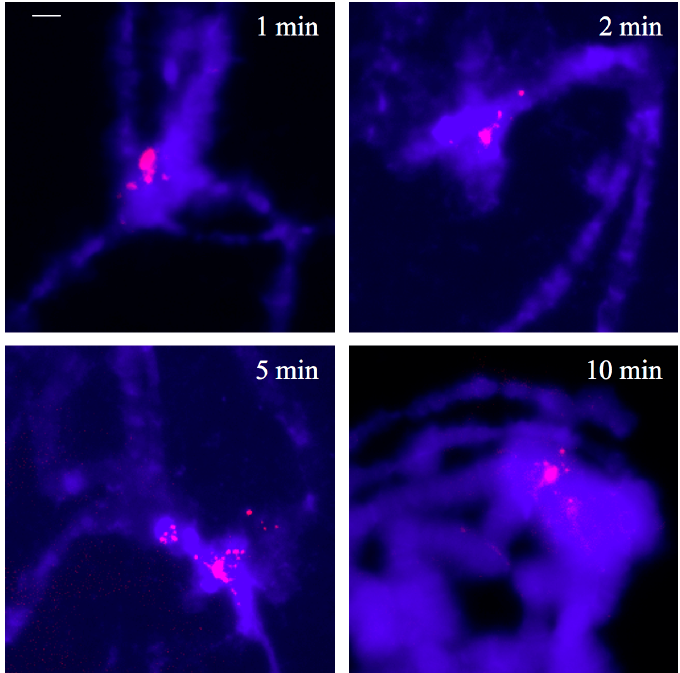
Figure 2. Polytene chromosome spreads of D. melanogaster wild type were treated with RNase A/RNase H mixture followed by proteinase K digestion in a time course experiment and subsequent immunological detection of triple-stranded DNA. DAPI staining (blue signal) and antibody labelling (red signal) were superimposed. Scale bar represents 25 µm.